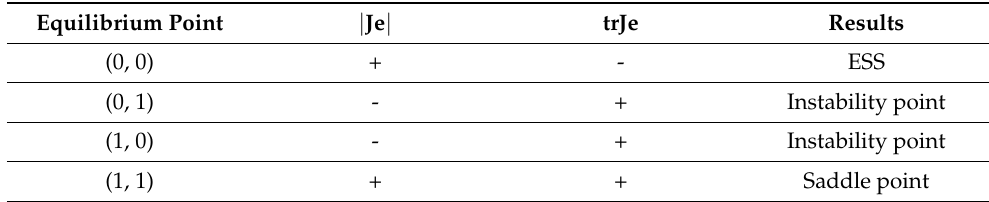
Table 2. Equilibrium results when the expected benefits for one of the residents and the government are less than the costs they pay.